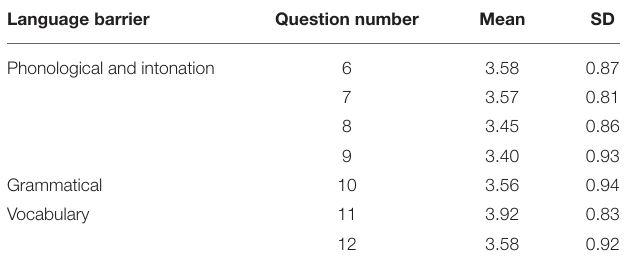
TABLE 5 | Language barriers statistics. TABLE 6 | Non-language barrier